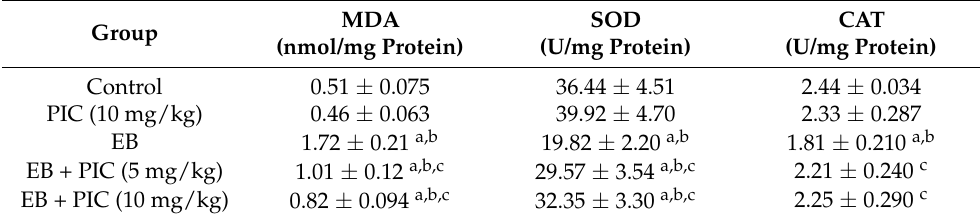
Table 3. Effect of PIC SNEDDS (5 and 10 mg/kg) on uterus oxidative status in EB induced EH in rats.